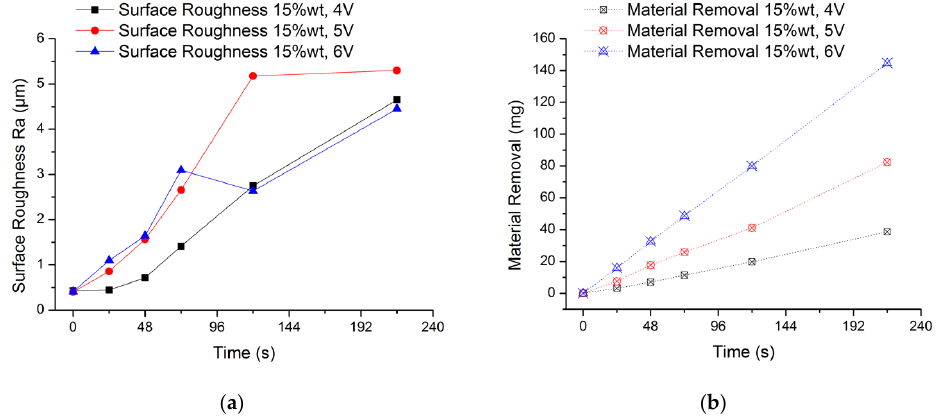
Figure 6. Experimental results of electrolysis in EMAF process. ( a ) Changes of surface roughness during processing and ( b ) changes of material removal during processing.